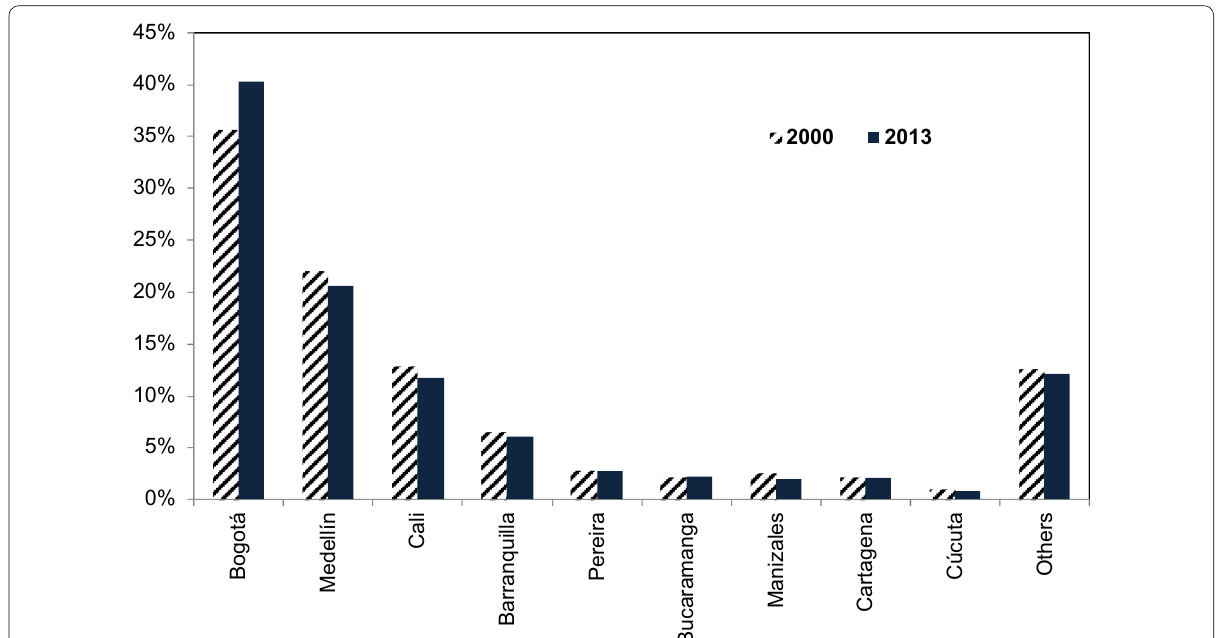
Fig. 1 Contribution to employment of manufacturing subsector by city (% of total) ( Source Dane-AMS and authors’ calculations)